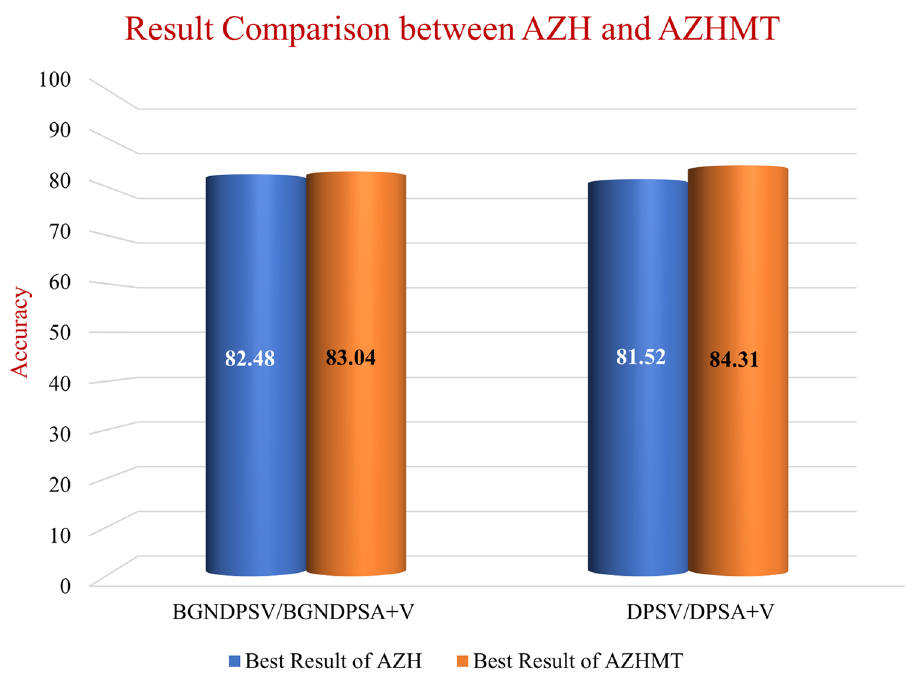
Figure 8. Comparison between the highest results (accuracy) of AZH and AZHMT